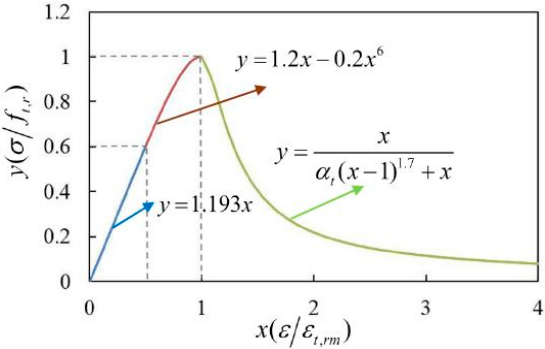
Figure 12. The calibrated tensile constitutive relation curve